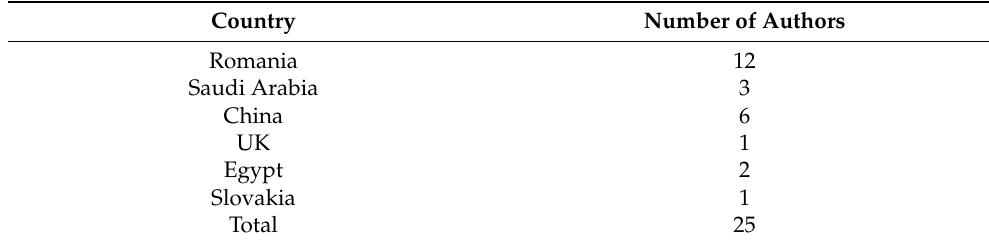
Table 1. Geographic distribution of authors by country.